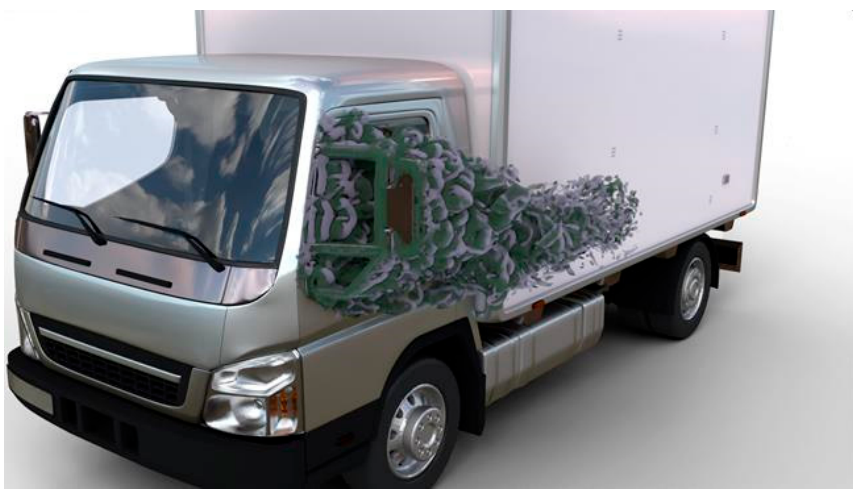
Figure 2. Visualization of LES calculation results showing turbulence as an unwanted phenomenon.